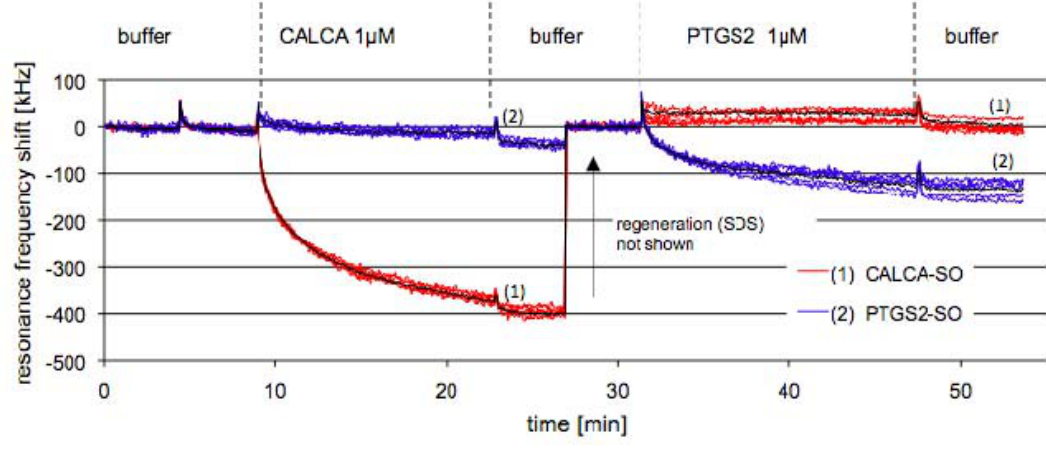
Figure 5. The frequency response of selected pixels of one FBAR chip: The red curves (5 pixels) show responses for surfaces functionalized with S-S-CALCA/Lipa-DEA and the blue curves (5 pixels) for surfaces functionalized with S-S-PTGS2/Lipa-DEA. The black curves represent the average of the 5